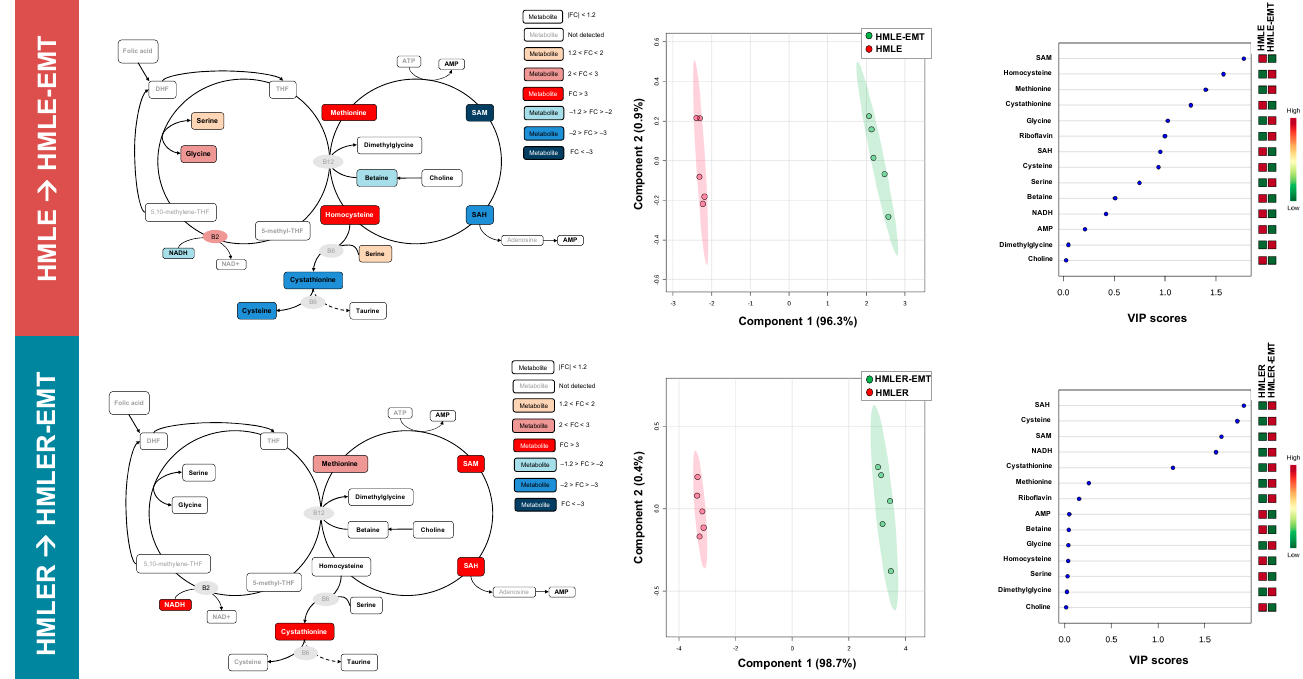
Figure 5. Homocysteine–methionine 1C metabolism fingerprints of non-tumorigenic and tumorigenic EMT (I). Left panels: Homocysteine–methionine 1C metabolites from non-tumorigenic HMLE-EMT and tumorigenic HMLER-EMT mesenchymal cells were extracted and quantitatively analyzed by UHPLC-ESI-QqQ-MS/MS and compared with those of non-tumorigenic HMLE and tumorigenic HMLER parental counterparts. Significantly increased and decreased metabolites (EMT vs. epithelial controls) are shown using brown-red and light blue-dark blue color scales, respectively. Middle panels: Two-dimensional score plots of the partial least square discriminant analysis (PLS-DA) mod- els of the UHPLC-ESI-QqQ-MS/MS-based homocysteine–methionine 1C metabolomic profiling of HMLE/HMLE-EMT and HMLER/HMLER-EMT cells. The X and Y axes represent the combinations of the different 1C metabolites analyzed, showing the maximum separation between groups. Right panels: Key 1C metabolites separating the homocysteine–methionine 1C metabolomic profiles of HMLE/HMLE-EMT and HMLER/HMLER-EMT cells based on variable importance in projection (VIP) in PLS-DA analysis described in the middle panels. The VIP score, which is calculated as a weighted sum of the squared correlations between PLS-DA components and the original variable, summarizes the contribution of the metabolites’ importance in the PLS-DA model. The number of terms in the sum depends on the number of PLS-DA components found to be significant in distinguishing the